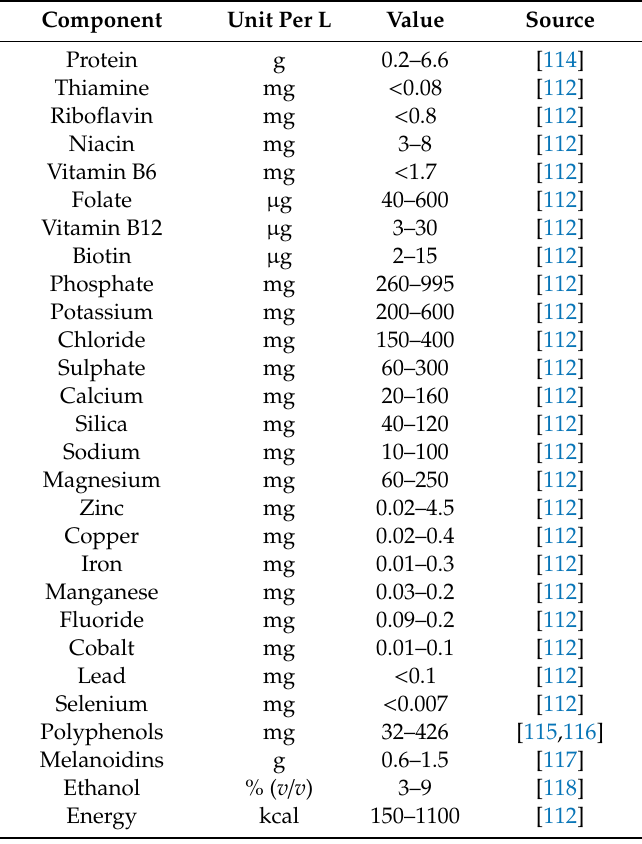
Table 2. The average levels of nutritive components in